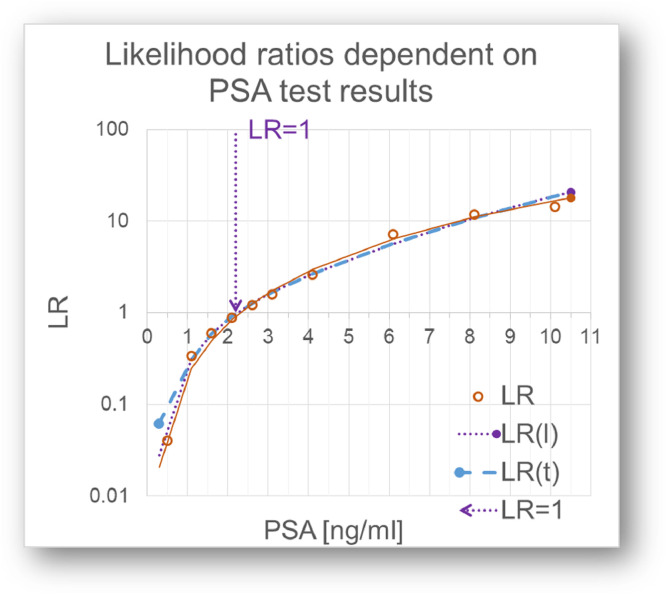
Relation between PSA test results an LRs. LR =1 corresponds to 2.2 ng/ml PSA. Values below 2.2 ng/ml have a LRs <1, values above have LRs >1.